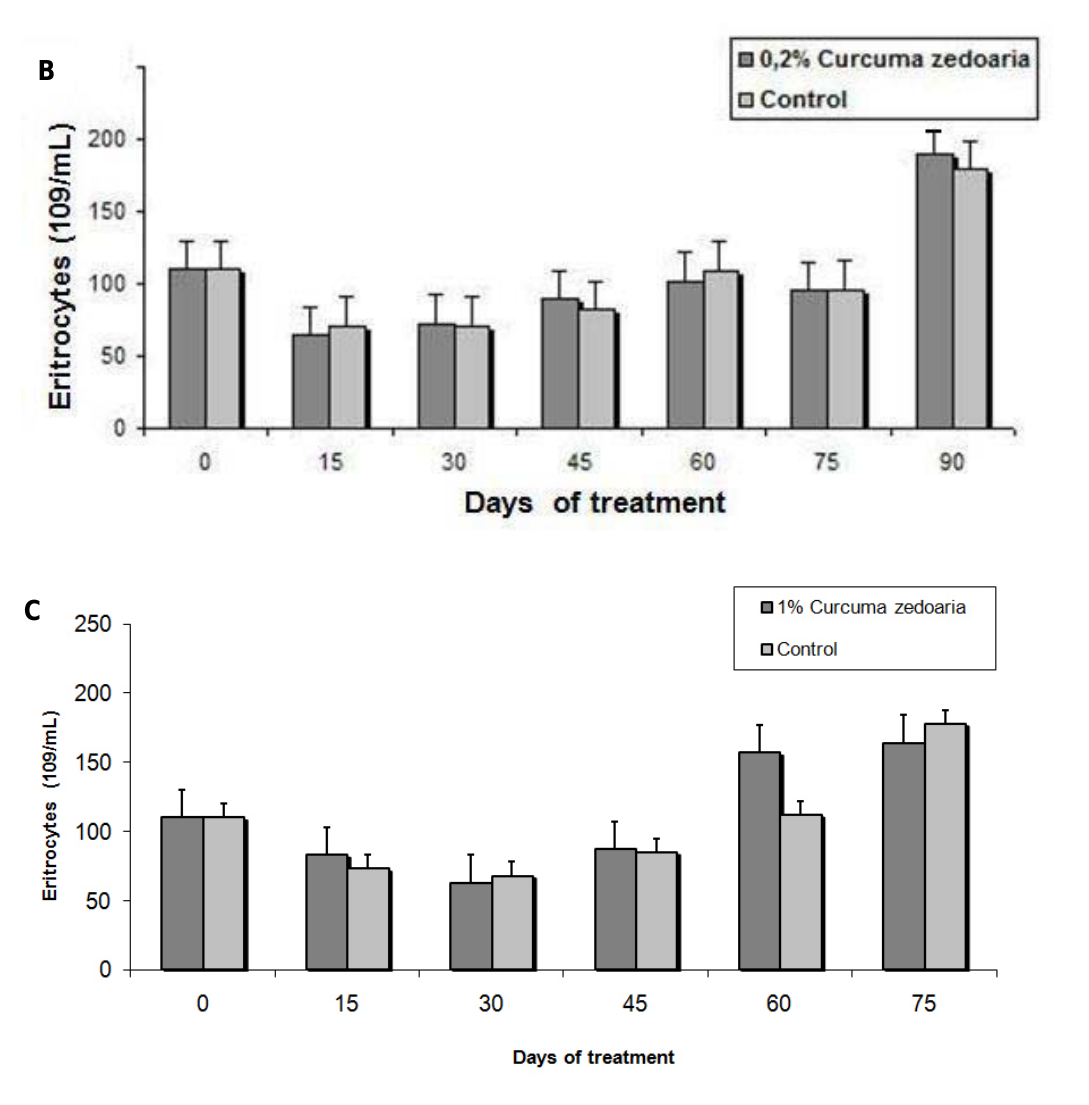
Figure 1. Analysis of total erythrocytes in the blood of C57BL/6J mice treated with ( A ) 0.1%; ( B ) 0.2% or ( C ) 1% Curcuma zedoaria crude extract. Data are expressed as mean ±